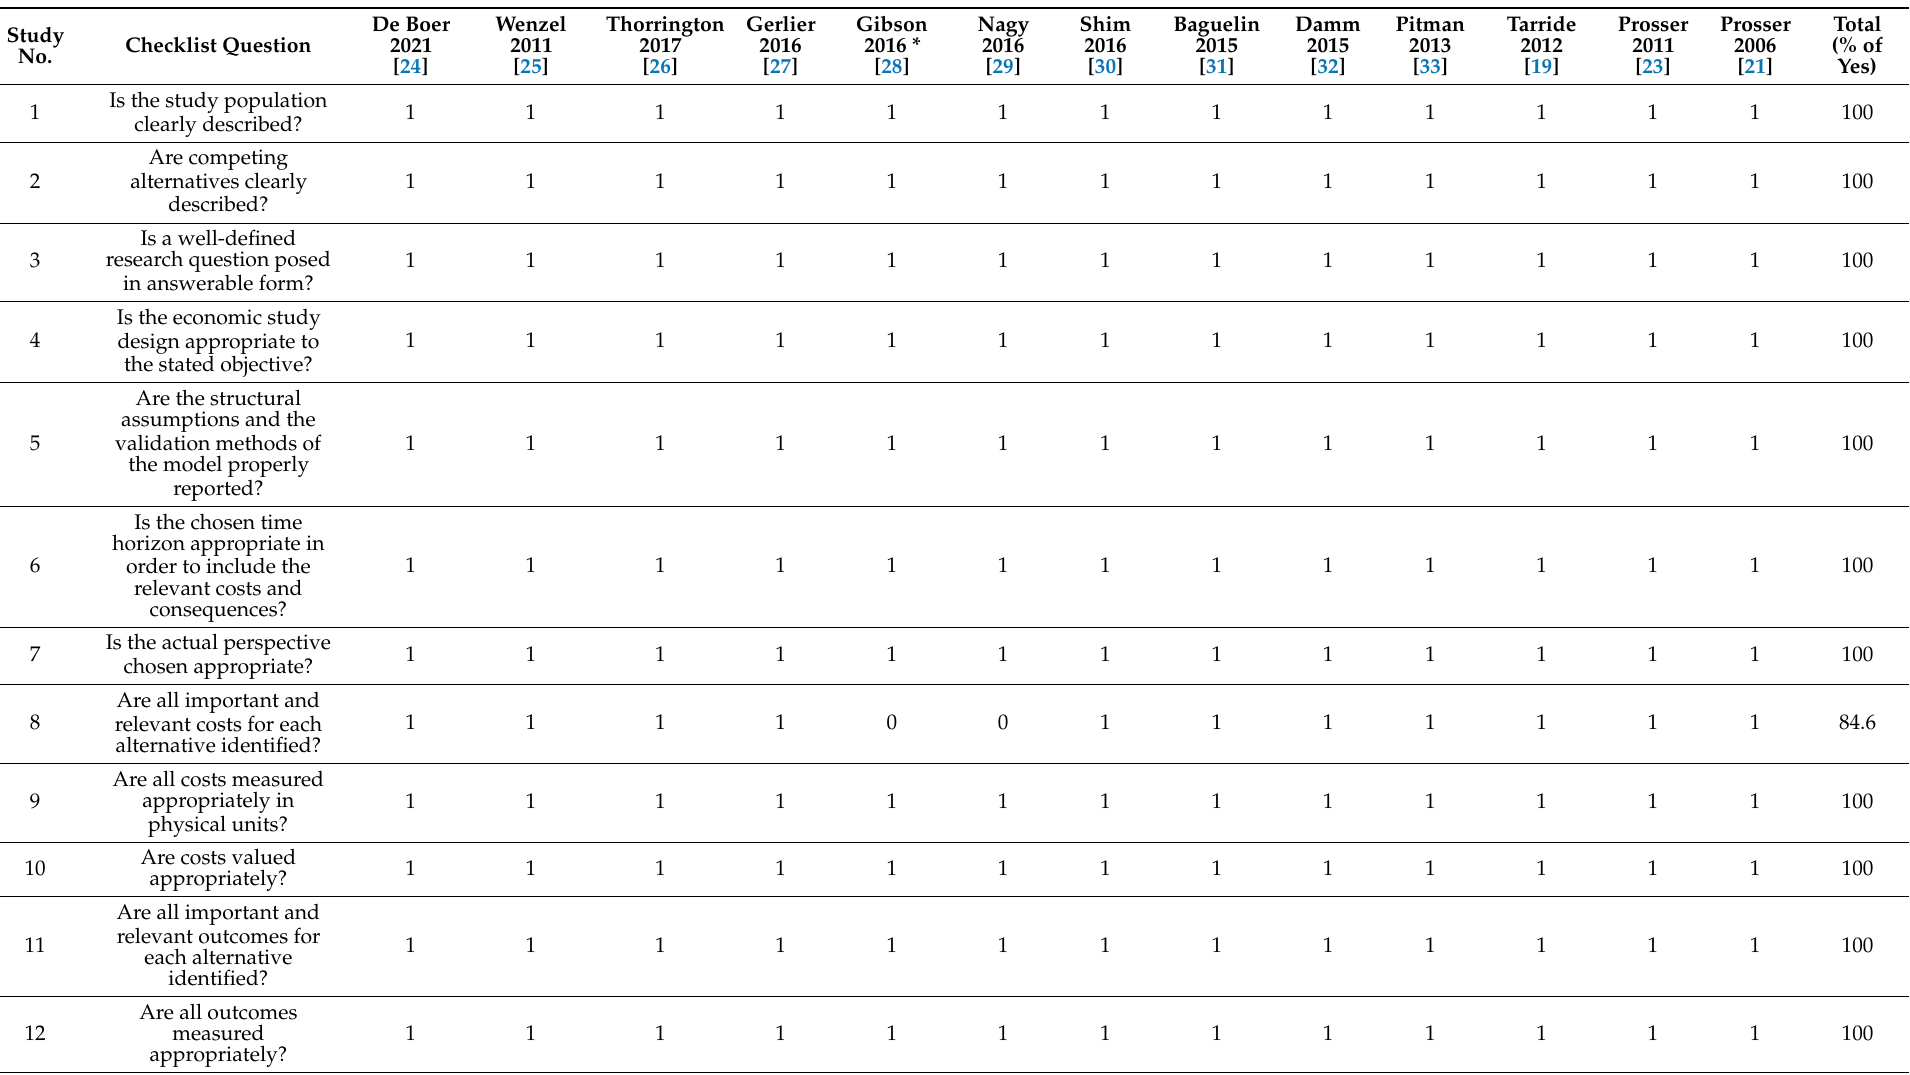
Table 3. The quality assessment of the studies